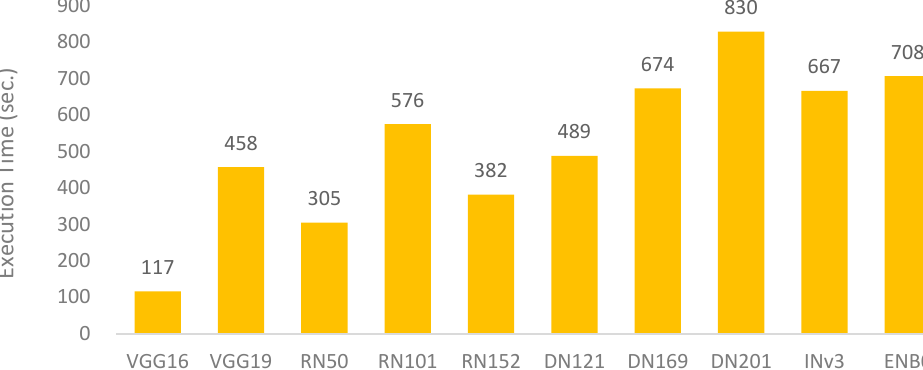
Figure 13. Hybrid evaluations by averaging F1-score, AUC, and kappa metrics.